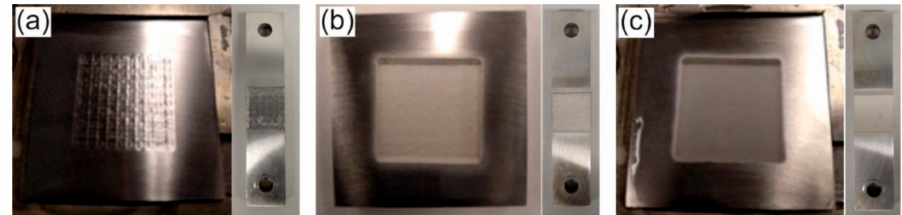
Figure 4. AA5083 samples for residual stress ( left ) and corrosion fatigue ( right ) testing after treatment: ( a ) LSP IR, ( b ) LPwC IR, ( c ) LPwC